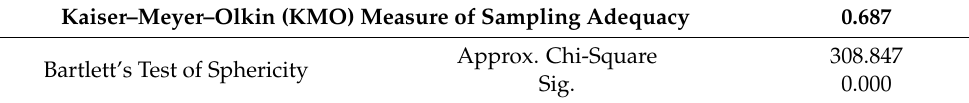
Table 5. Kaiser–Meyer–Olkin (KMO) and Bartlett’s Test.